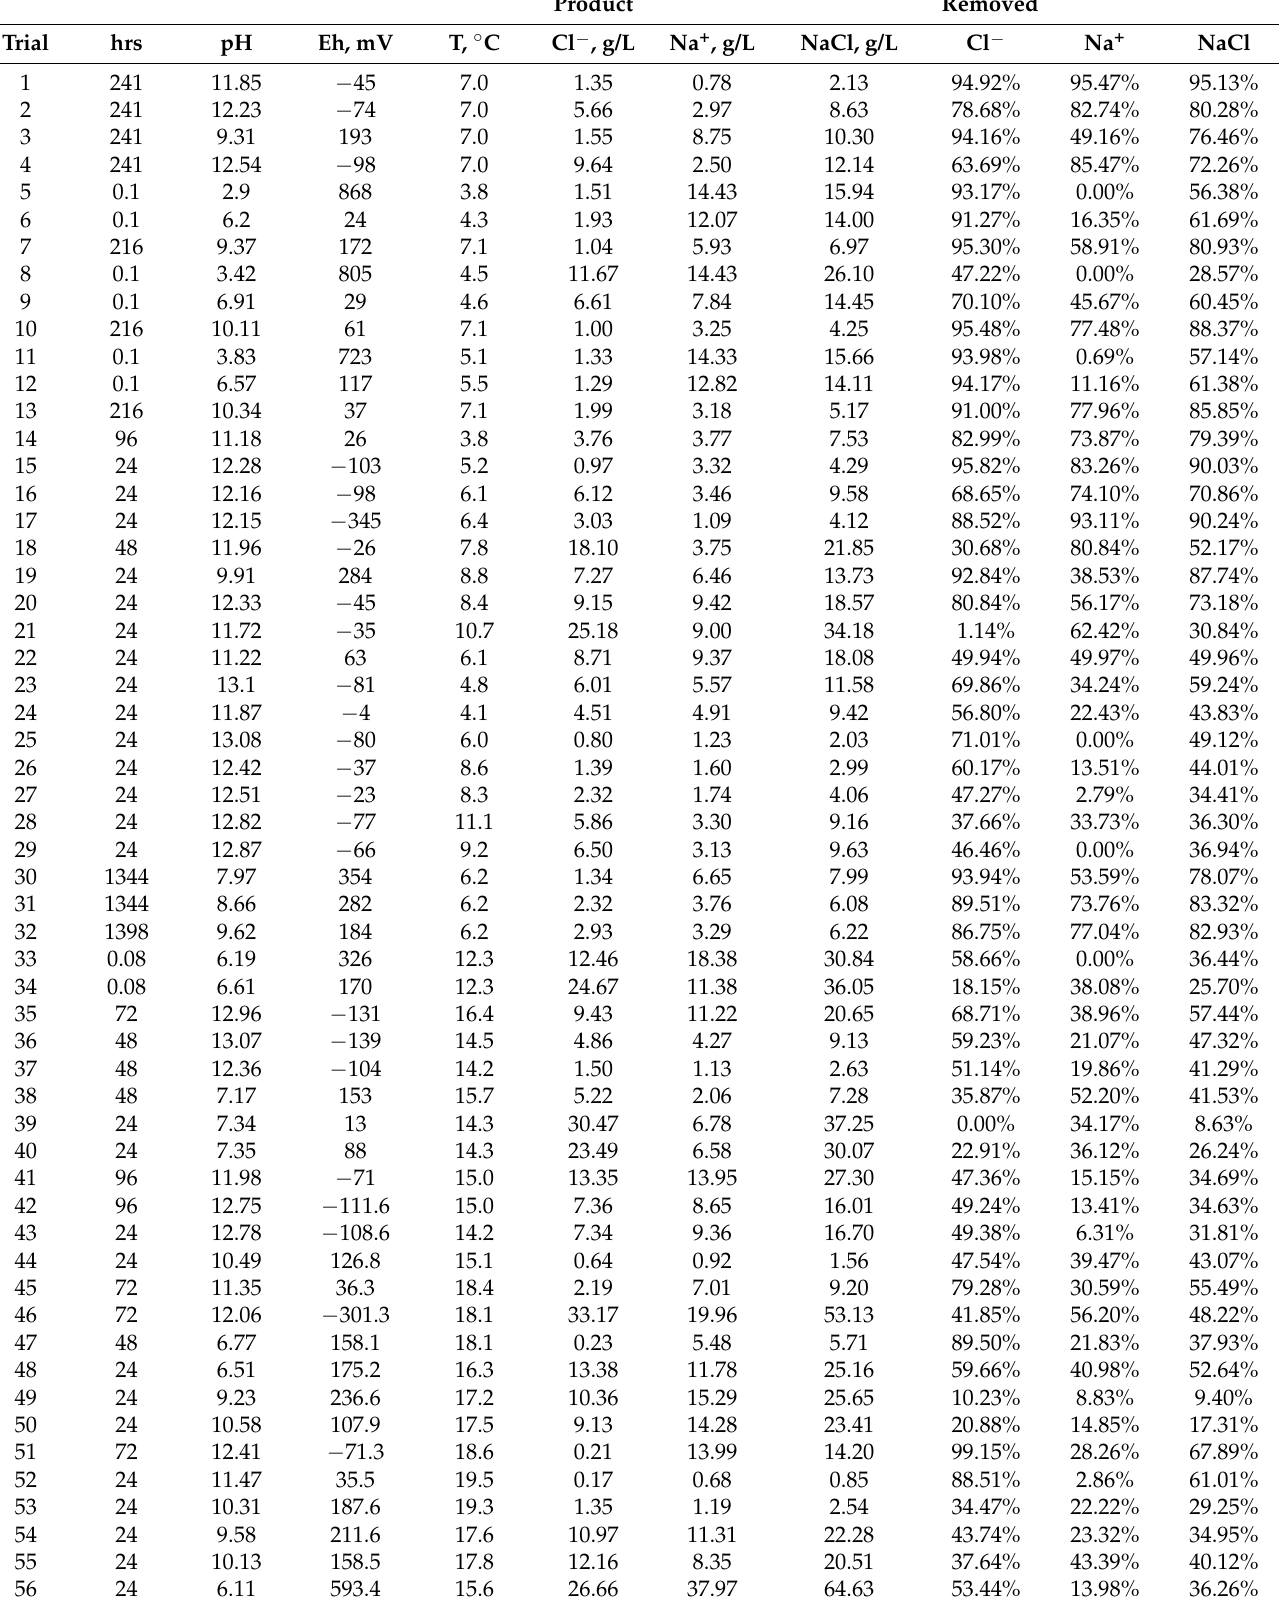
Table A2. Product water composition for polymer